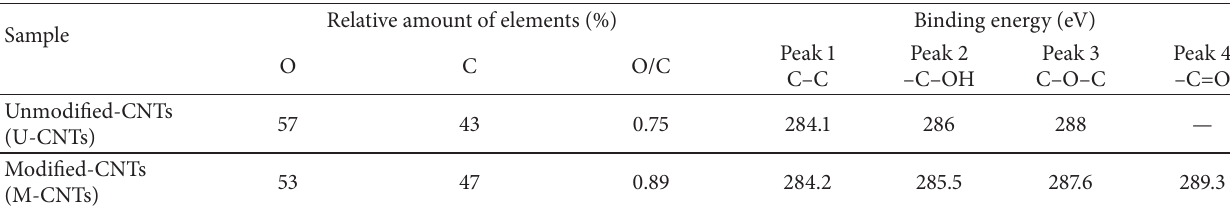
Table 1: Summary of the peak positions and the O/C area ratio of U-CNTs and M-CNTs from XPS measurement. Sample